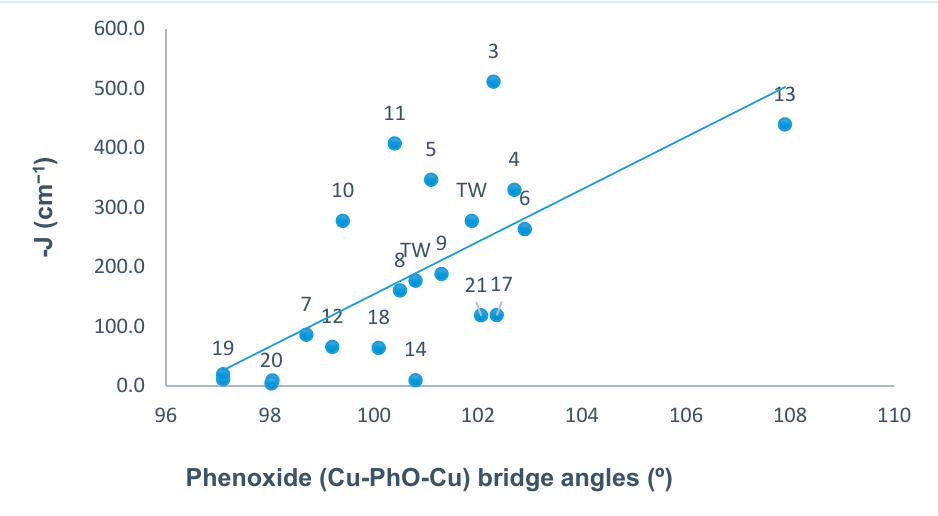
Figure 16. Plot of the antiferromagnetic interaction ( − J) vs. the Cu–OPh–Cu angle in dinuclear. ( µ -phenolate / µ -azido bridged) copper(II) complexes. Molecules 2020 , 25 , x